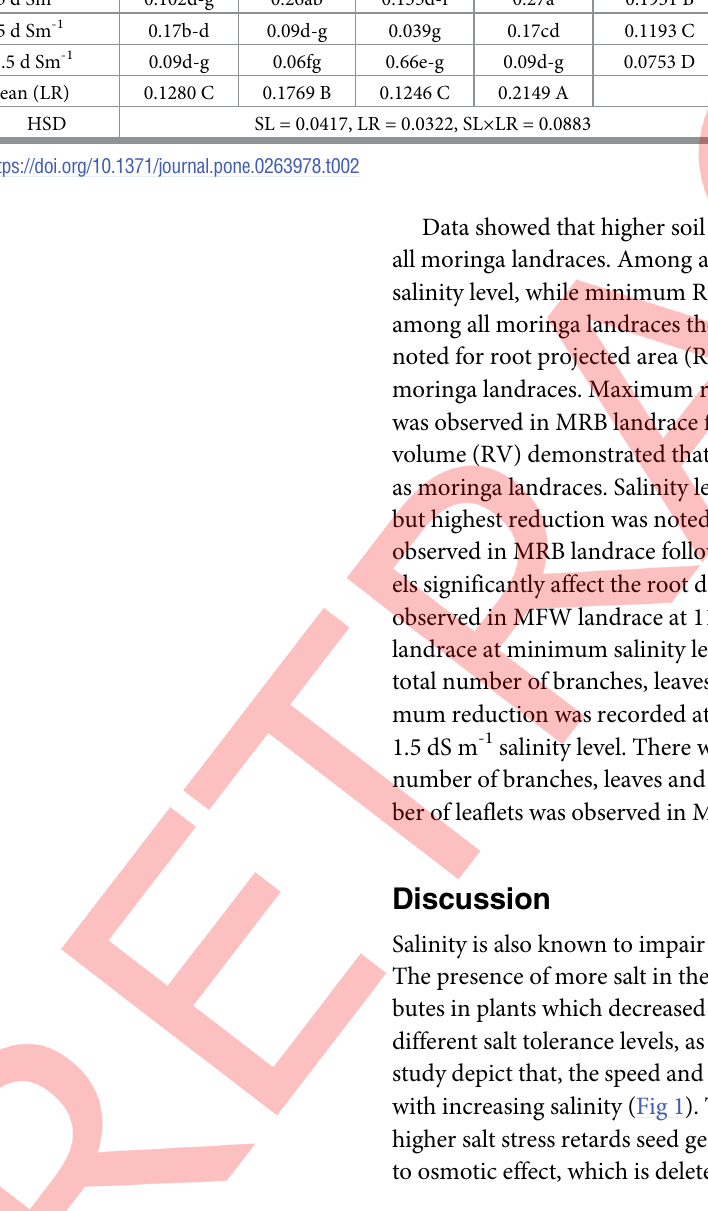
Table 2. Impact of various salinity levels on root attributes of moringa landraces. Treatments